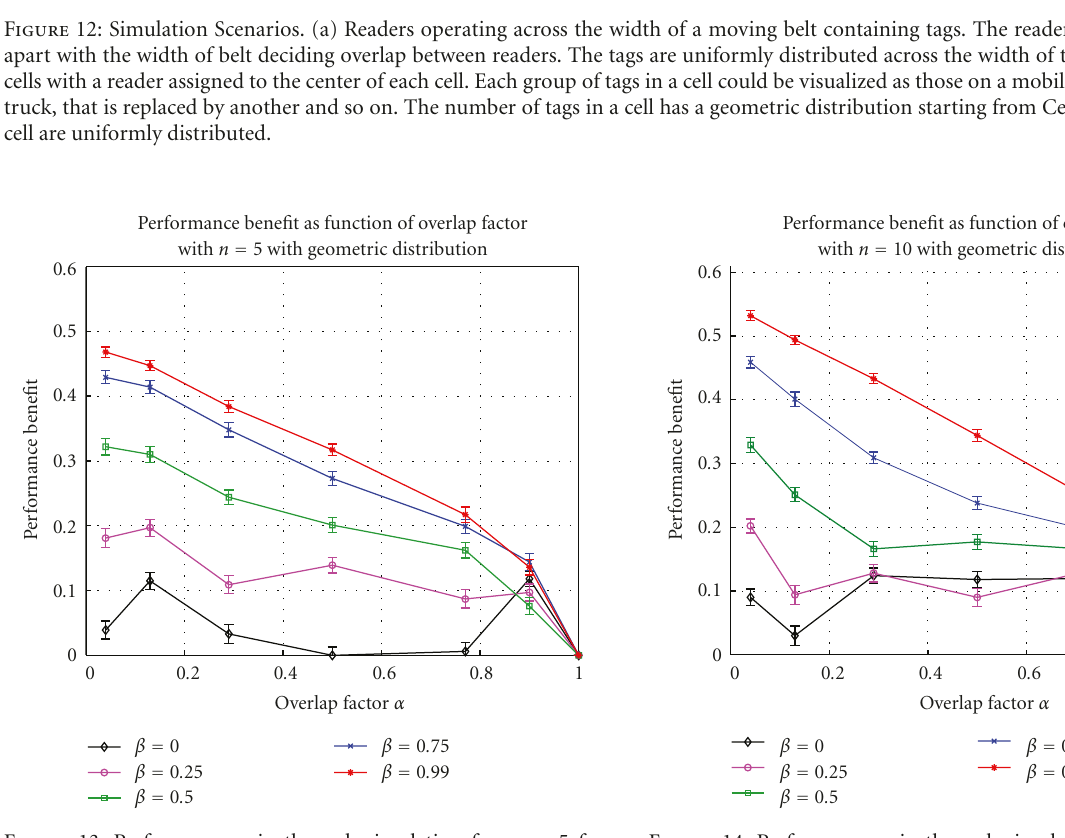
Figure 14: Performance gain through simulation for n = 10 for di ff erent values of geometric distribution parameter β as function of overlap factor,